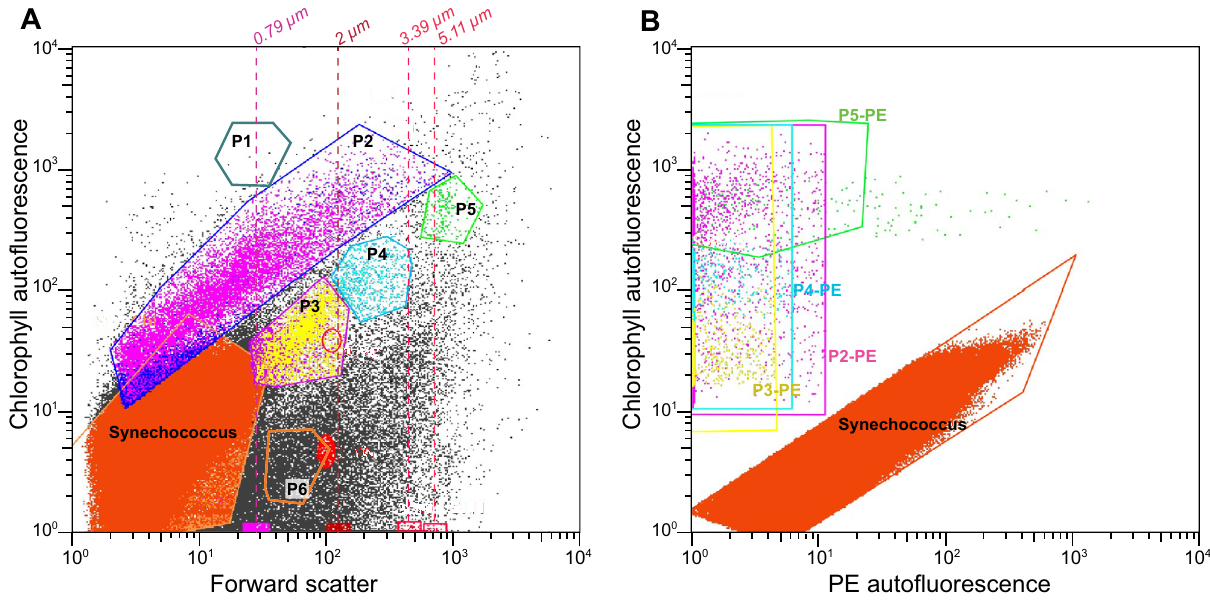
Figure 2. Example of a cytogram illustrating the gates used for small pigmented eukaryote population counts and sorting. Populations were first discriminated based on their position in the chlorophyll vs forward scatter cytogram ( A , all events represented) and then redefined in the chlorophyll vs phycoerythrine (PE) autofluorescence cytogram ( B , only events gated in A represented). In the later, we avoided Synechococcus overlapping with small pigmented eukaryote populations in A and cells exhibiting high PE fluorescence among the populations from cytogram B. Note that all 6 populations were never found present in the same sample. In particular, the sample represented here (S003 surface) did not contain P1 or P6, but the gates are represented nonetheless in panel A to provide an illustration for these populations. Note that the gating had to be adjusted between samples but the relative positions stayed similar to those illustrated here. The positions of standard size-calibrated non-fluorescent beads (dashed lines) along the x-axis were used to determine the size range of each gated population in cytogram A. Red ellipses mark the position of yellow-green reference beads of 1 and 2 µm (1-YG and 2-YG, respectively) used to maintain instrument alignment, although the bead clusters are not apparent in the sample since they were run separately (for details see “Methods”).